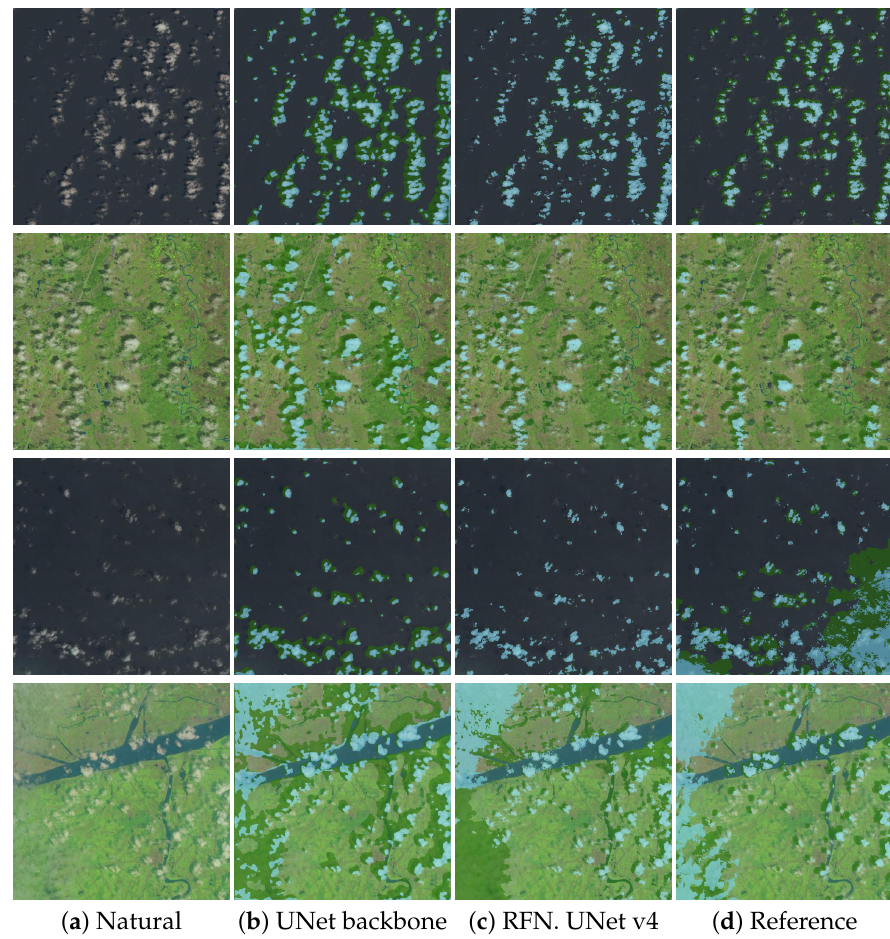
Figure 9. Detection generalization to RICE dataset. ( a ) Natural images, ( b ) UNet backbone, ( c ) Refined UNet v4, ( d ) Reference. Visually, our v4 yields edge-precise proposals for cloud and shadow regions even though our training labels are not sufficiently precise at the pixel level. Comprehensive retrievals of shadow regions with ambiguous edges and cirrus regions, however, remain